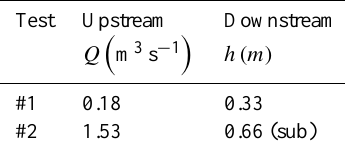
Table 3. Steady state over a bump. Figure 5. Dam-break test case. Initial state (dashed line). Numerical results (blue dots). Analytical solution (cyan line). Figure 5. Dam-break test case. Initial state (dashed line). Numeri- cal results (blue dots). Analytical solution (cyan